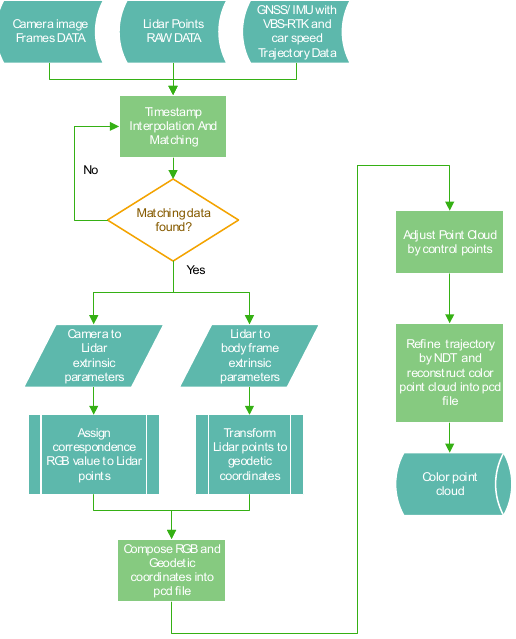
Figure 7. Flowchart of the proposed color point cloud reconstruction.